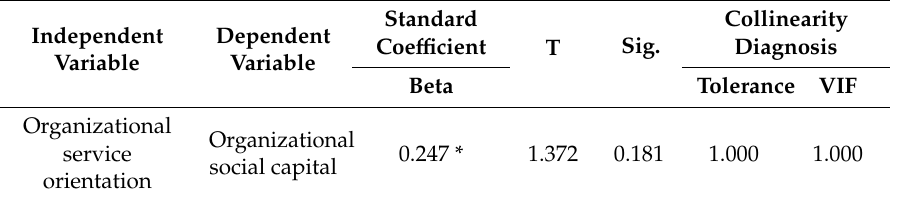
Table 10. Regression analysis of organizational service orientation and organizational social capital.